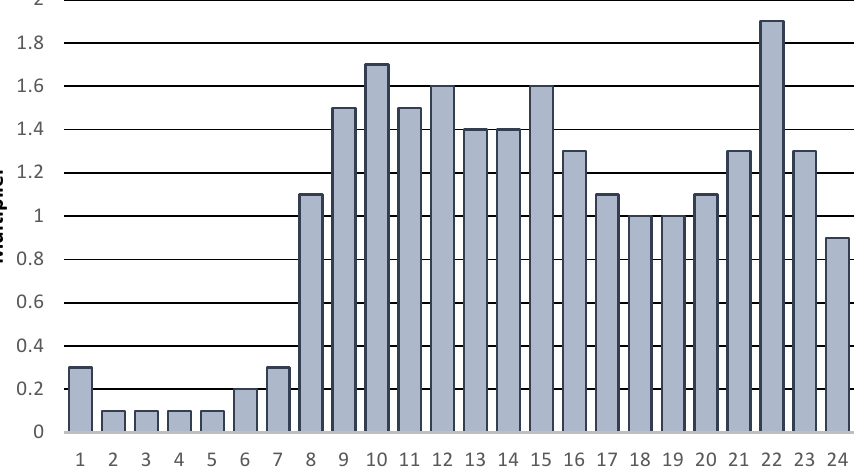
Figure 4. Demand pattern for the MTF network. Table 4. Case study coefficients for calculating CAPEX